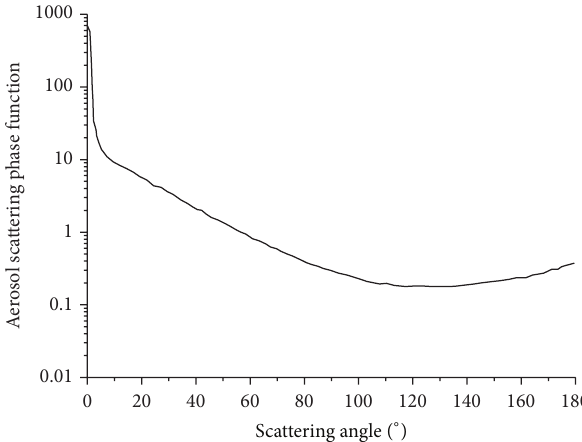
Figure3:Thecurveofcontinentalaerosolscatteringphasefunction.